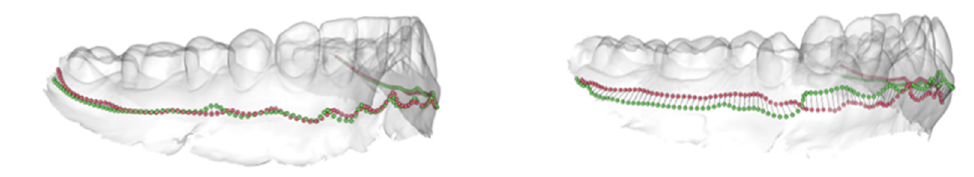
Figure 5. Best ( left ) and worst ( right ) prediction of the MG-BL of the mandible based on the Figure 5. Best (left) and worst (right) prediction of the MG-BL of the mandible based on the average average error.